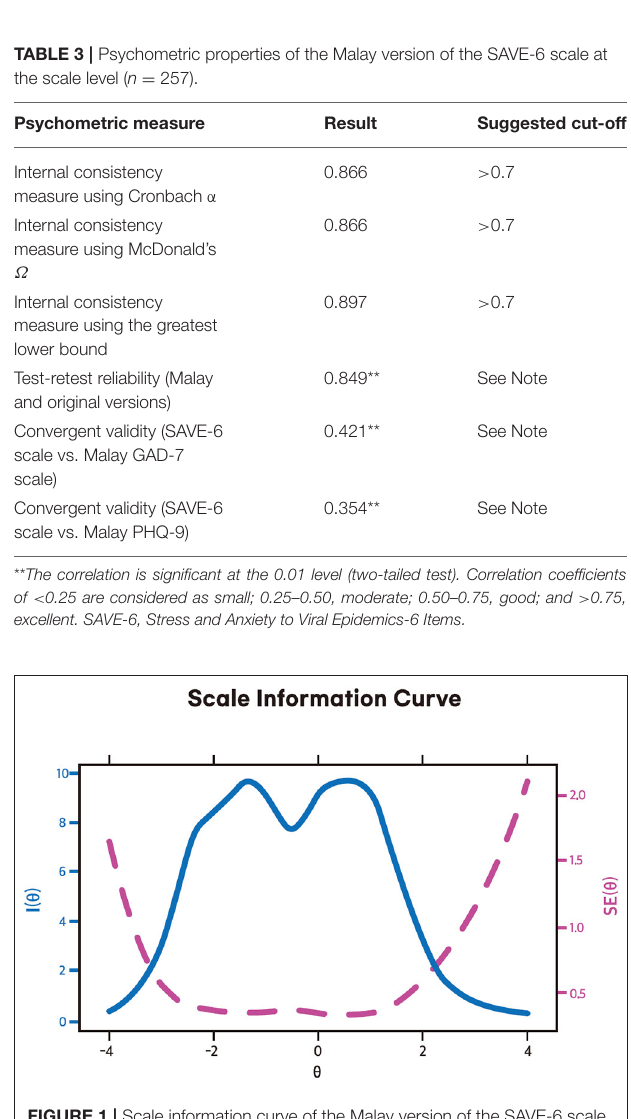
FIGURE 1 | Scale information curve of the Malay version of the SAVE-6 scale among the general